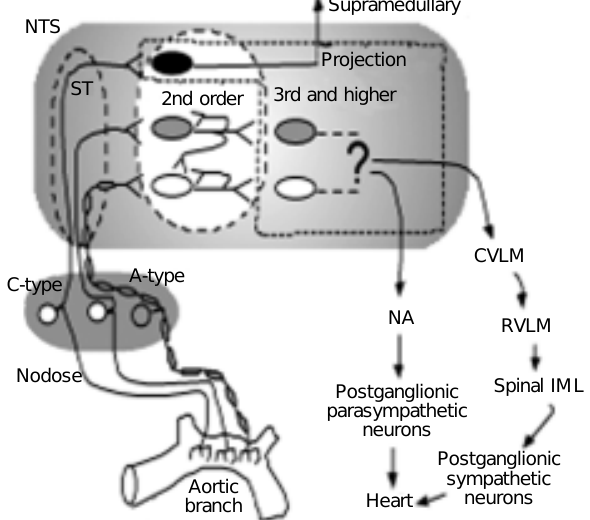
Figure 1. Schematic presentation of the basic organization of brain stem reflex networks for autonomic cardiovascular control. Afferents enter the nucleus tractus solitarius (NTS) to contact second order NTS neu- rons that have either myelinated, A-type, or unmyelinated, C-type, axons. Second order neurons may contact other neurons within the NTS (i.e., third order interneurons) or send axons out of the NTS to other brain areas (e.g., supramedullary regions such as the hypothalamus). Promi- nent projections are nucleus ambiguus (NA) and the rostral ventrolateral medulla (RVLM). Neurons in the caudal ventrolateral medula (CVLM) provide feedback to premotor sympathoexcitatory neurons in the RVLM. Preganglionic sympathetic neurons are found in the spinal cord at the intermediolateral cell column (IML). ST = solitary